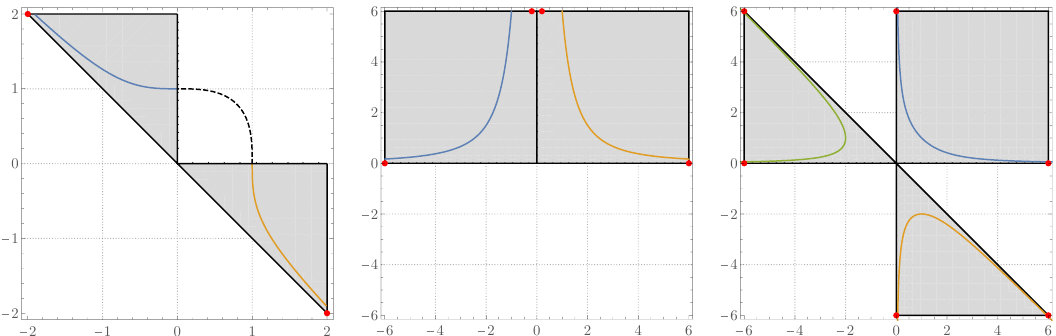
Figure 3 . Shaded regions indicate where ˆ κ > 0 and ˆ G is positive definite, for case 1 (left), case 2 (middle) and case 3 (right) from table 3. The coloured lines are isochores (taking ˆ κ = 6 ) and the red dots indicate boundaries for which ˆ κ vanishes at the boundary. The dashed line in case 1 indicates the isochore outside the consistent